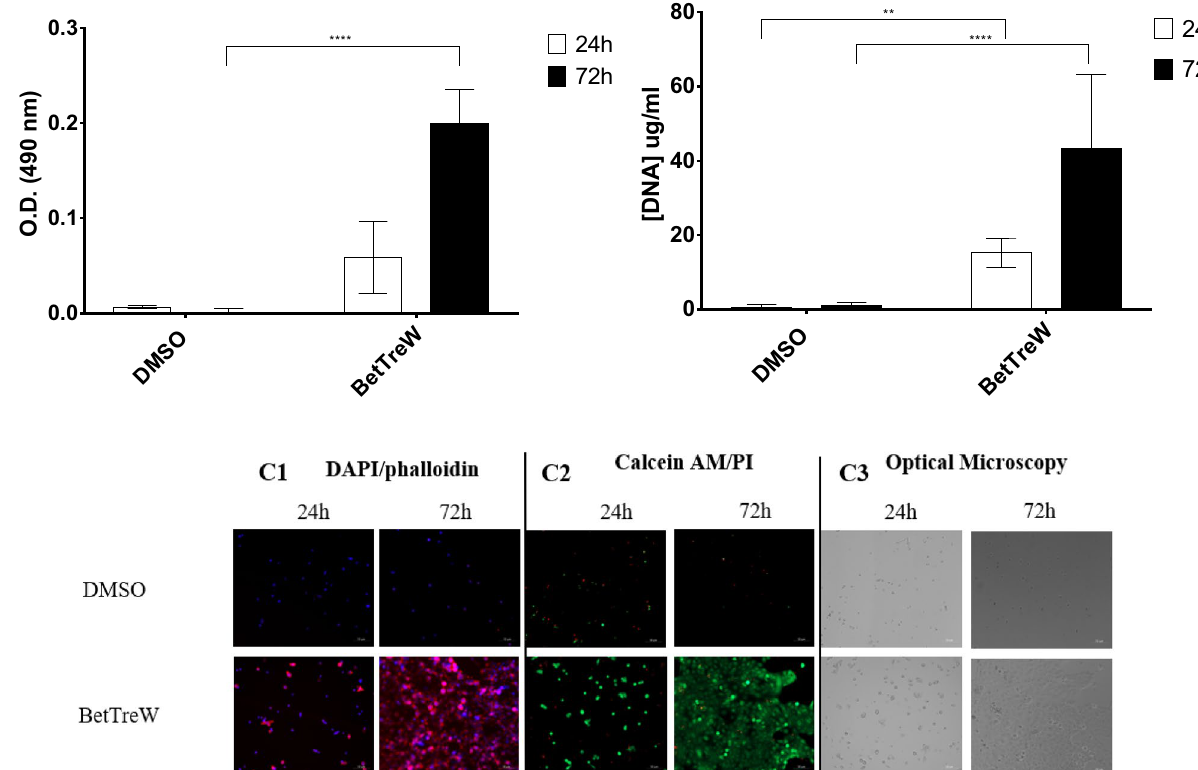
Figure 3. Assessment of the post-thawing recovery of HacaT cells. MTS assay ( A ) and DNA Assay ( B ) after 24 h, 48 h, and 72 h of culture. Data represent means ± SD (n = 3). Statistically significant differences were determined by Dunnett’s multiple comparisons test and are represented in asterisks: ** p < 0.01; *** p < 0.05; and **** p = 0.0001, two-way ANOVA. The absence of asterisks means that there are no significant differences when compared with values of DMSO at the corresponding time points. Post-thawing DAPI/Phalloidin assay (cells nuclei were stained blue by DAPI and F-actin filaments in red by phalloidin) ( C1 ), Live/Dead fluorescence assay (living cells were stained green by calcein AM and dead cells red by PI) ( C2 ) and Optical microscopy ( C3 ) of HacaT cells at 24 h and 72